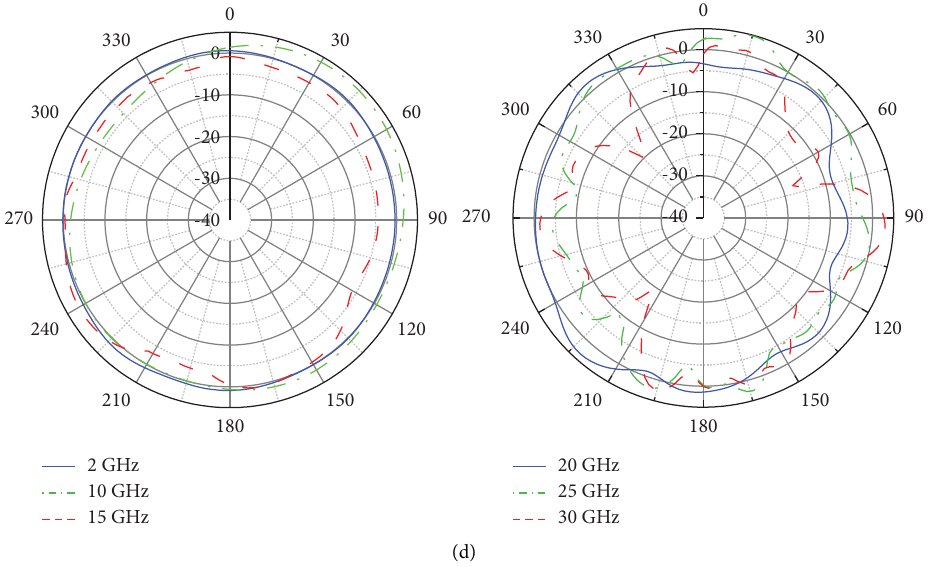
Figure 13: E . H -plane simulation and real measurement results. (a) E -surface simulation results. (b) H -surface simulation results. (c) E - surface real measurements results. (d) H -surface real measurements results.